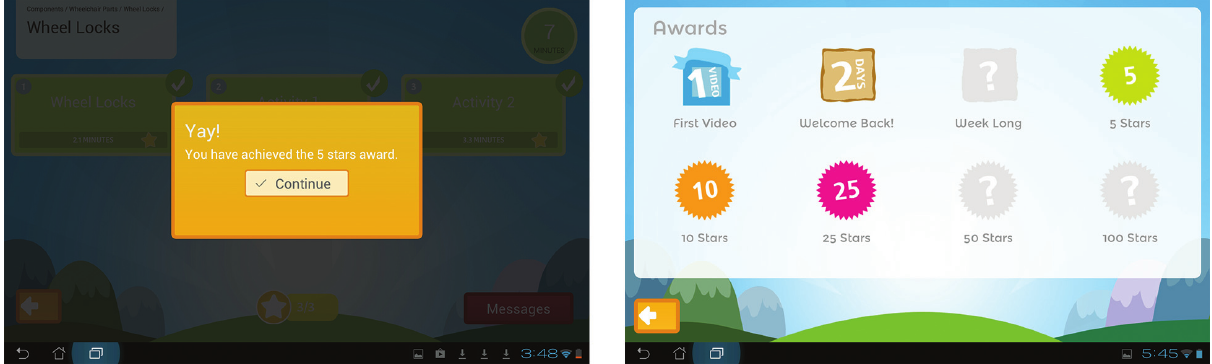
Figure 5. Award pop-up with Awards Earned windows in post-pilot